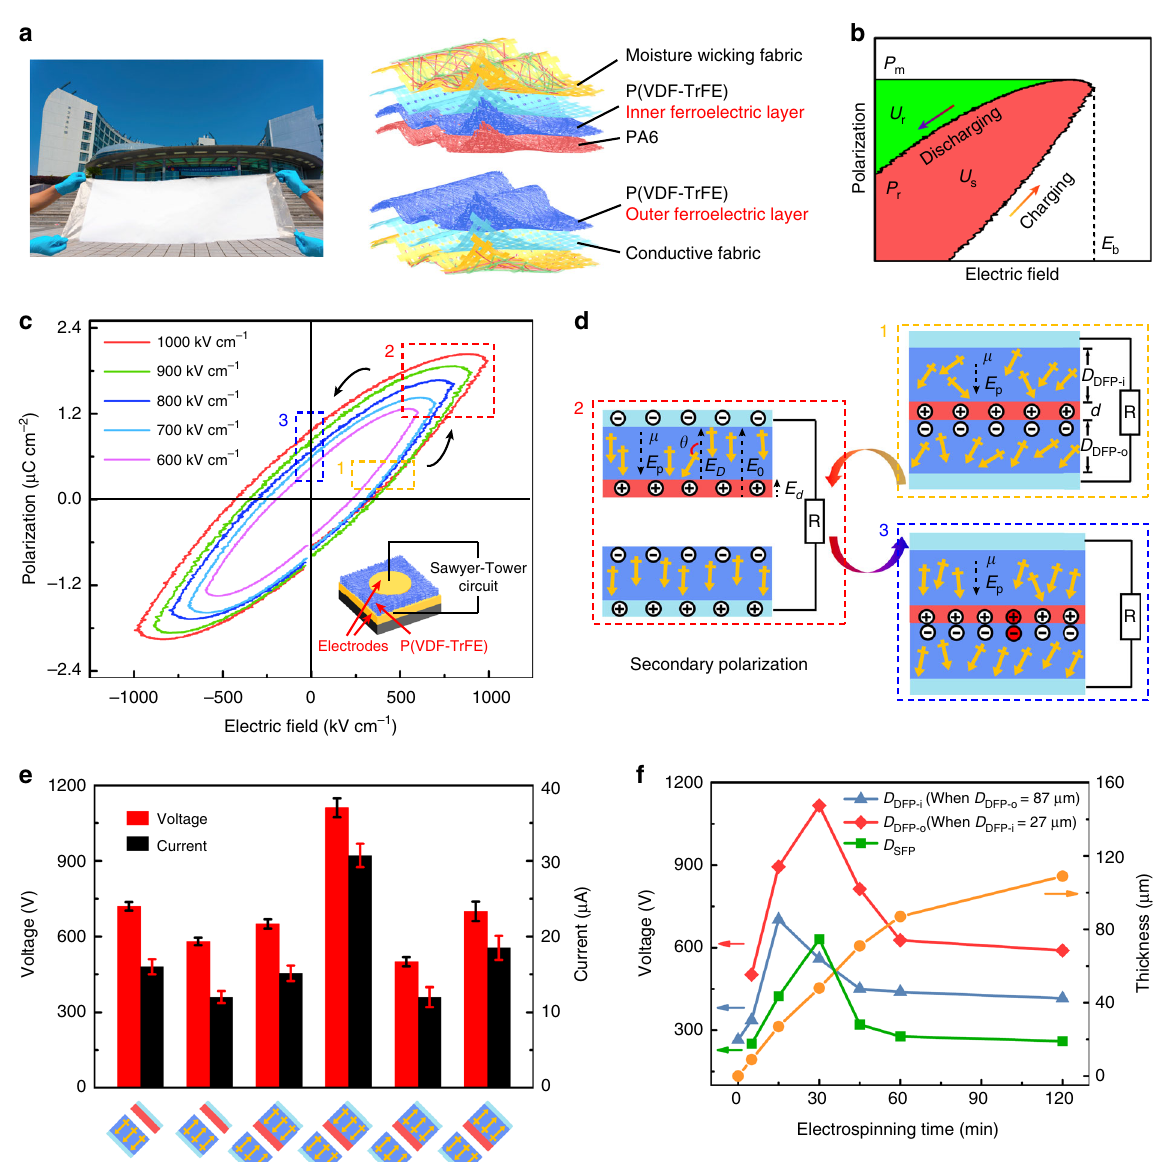
Fig. 1 The structure of the e-textile and the proposal of tribo-ferroelectric synergy model. a The physical (one piece of the e-textile 105 × 35 cm) and structural diagram of an all- fi ber contact-separation mode tribo-ferroelectric synergistic e-textile. b The P-E loop of P(VDF-TrFE) nano fi ber ferroelectricity. U U s and r are the energy stored in (red area) and released from (green area) ferroelectricity during the change of applied electric maximum and remnant polarization intensity, respectively. E b is the highest electric fi eld a dielectric can sustain. c The hysteresis loop of P(VDF-TrFE) nano fi ber ferroelectricity under different applied electric fi elds. d Schematic diagram of tribo-ferroelectric synergistic model between ferroelectricity and internal electric fi eld of triboelectric device. E 0 , E D , E d , E p , E e are the electric fi eld intensity between dielectric and conductive layer, inside the ferroelectric layer, inside the PA6 layer, generated by the other dipoles and acting on dipoles effectively, respectively. D and d are the thickness of ferroelectric layer and PA6, μ is dipole moment, θ is the angle between dipole moment and E e . e In fl uence of the primary polarization direction of P(VDF-TrFE) nano fi bers on performance of the e-textile. The error bars correspond to standard deviation caused by the measurement noise. f Effect of inner/outer ferroelectric layer thickness on performance of the e-textile. The e-textile tested in experiment were uniformly sized to 4 × 6